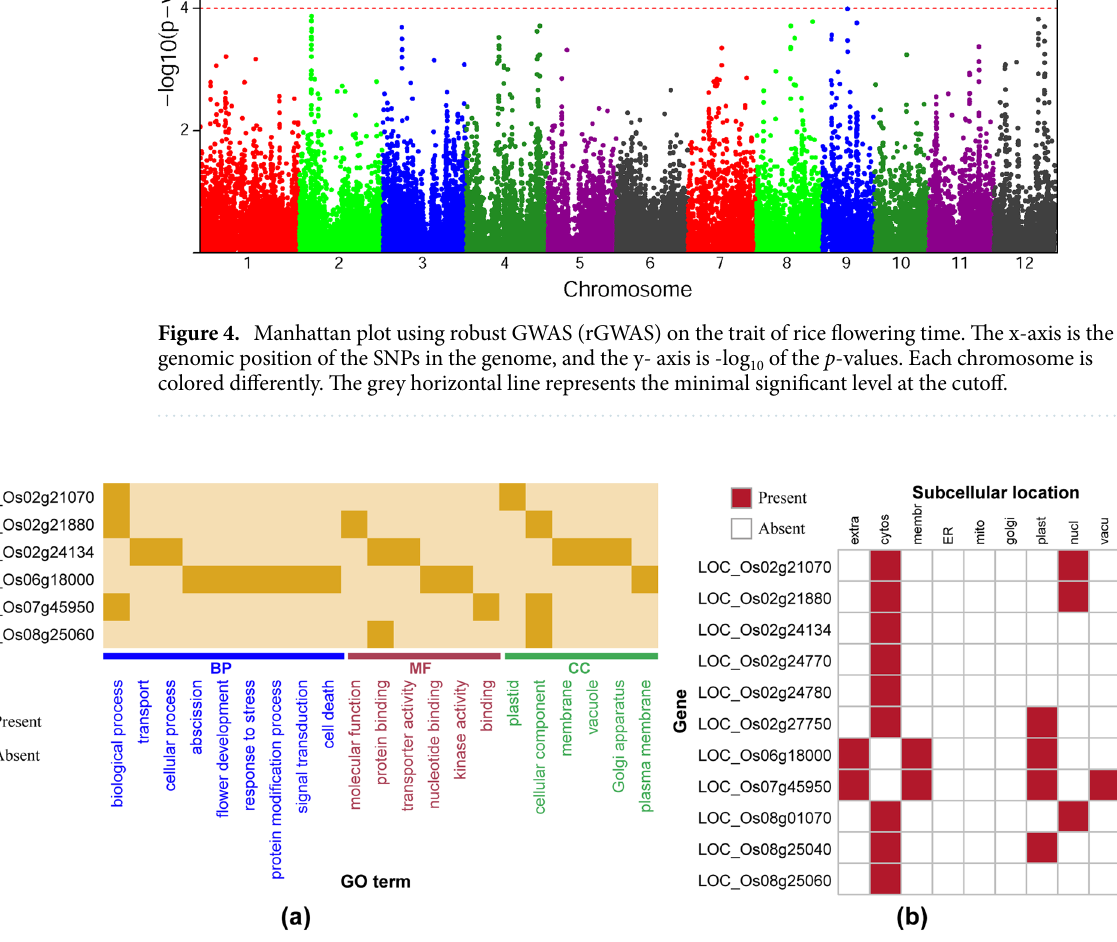
Figure 5. Expression map of GO and SCL for the 11 candidate genes. ( a ) Represents the expression map of the functional pathways viz., biological process (BP), molecular function (MF), and cellular component (CC) of the six candidate genes. ( b ) Represents the predicted subcellular location (SCL) of candidate genes in 10 molecular organs viz., cytosol (cytos), endoplasmic reticulum (ER), extracellular (extra), golgi apparatus (golgi), membrane (membr), mitochondria (mito), nuclear (nucl), peroxisome (pero), plastid (plast) and vacuole